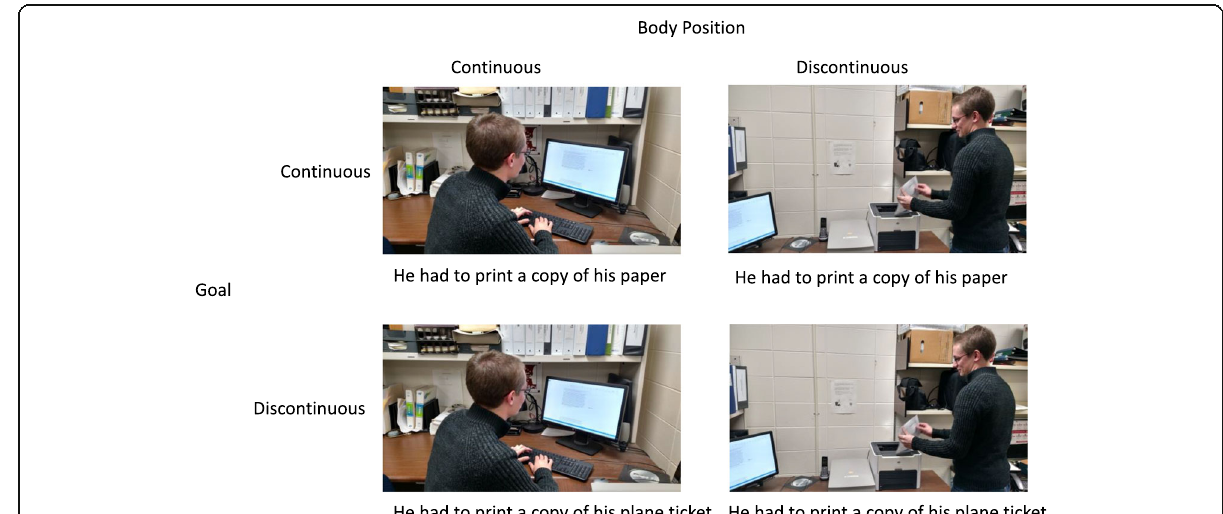
Fig. 4 Example critical slide in the four conditions of the 2 (Goal: Continuous and discontinuous) × 2 (Body position: Continuous and discontinuous)